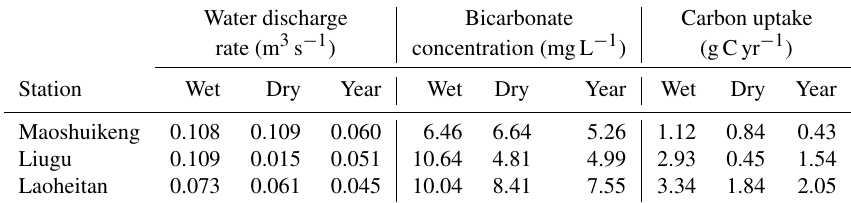
Table 3. Standard deviation of production flow, ion concentration, and carbon sink for each station in the dry and wet seasons and over the whole